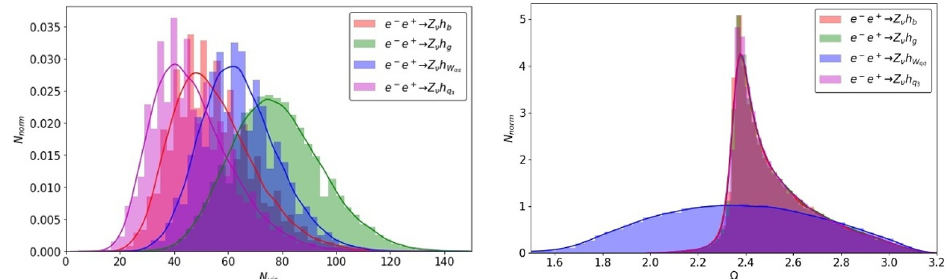
Figure 6 . Distributions of the visible-particle number in each event (left) and the included angle between its two jet ancestral partons (right), for the two-jet samples. For the Z (cid:23) h W two partons are from the W boson with a larger mass. The solid curves are generated by (cid:12)tting.